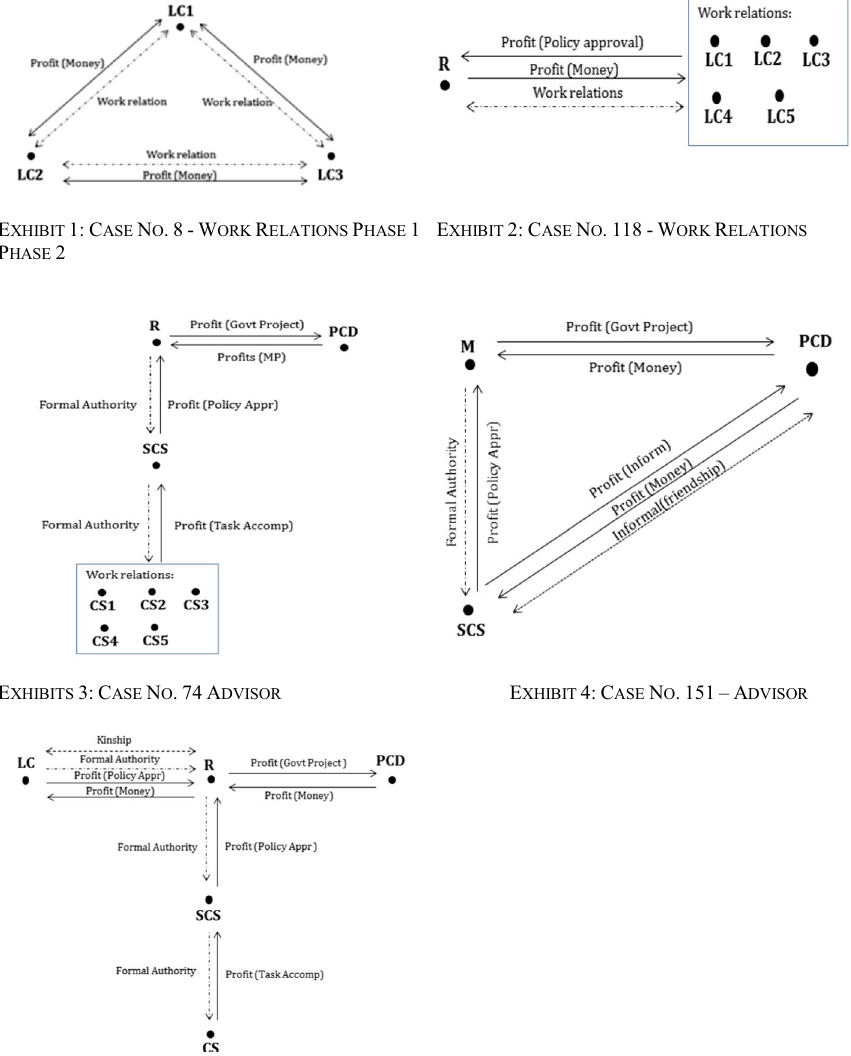
Fig. 4 Case examples of non-compound and compound role structures. Legend: LC: local council; R: head of region, R & M: head of region; SCS: senior civil servant; PCD: private actor; CS: civil servant. R: head of region; LC: local council; SCS: senior civil servant; CS: civil servant; PCD: private